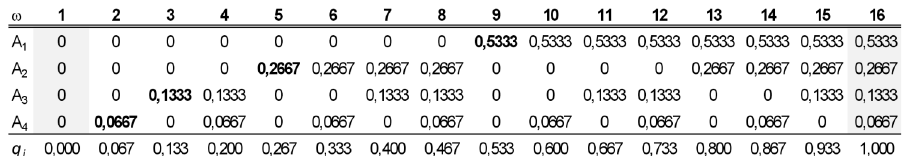
Space for k = 4 and